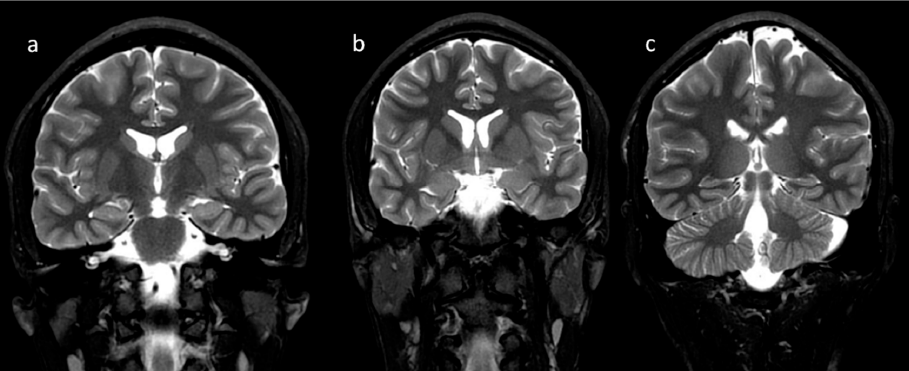
Figure 4. Completion of myelination on brain MRI and differences in signal intensity between the basal ganglia and the surrounding brain—coronal T2-WI; putamen and caudate nucleus head ( a , b ); thalamus and caudate body ( c ).